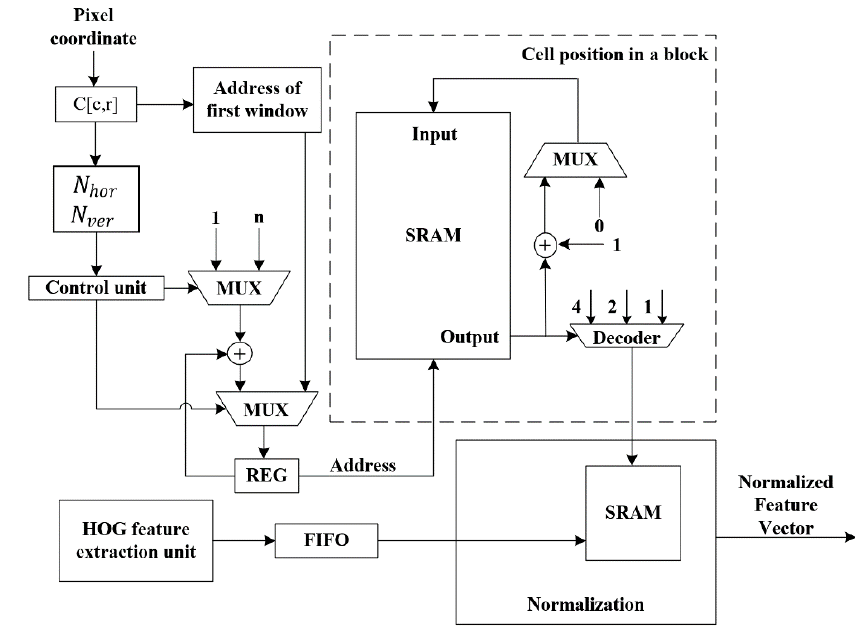
Figure 5. Hardware architecture of SBSSDW, the pixel index, N hor and N ver is calculated by this module.